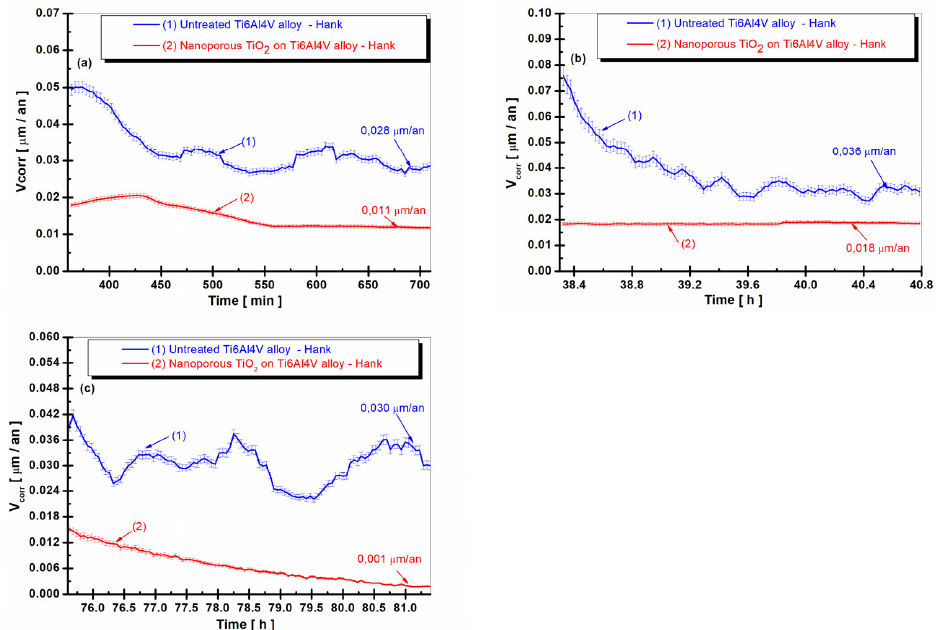
Figure 10. Comparative evolution of the average values for the corrosion rate (V corr ) during the immersion period in Hank’s biological solution: ( a ) after 6 h (360 min); ( b ) after 38 h (2298 min); ( c ) after 75.5 h (4534 min). (1) the untreated Ti6Al4V alloy and (2) the treated Ti6Al4V alloy with the electrochemically formed nanoporous titanium oxide film.